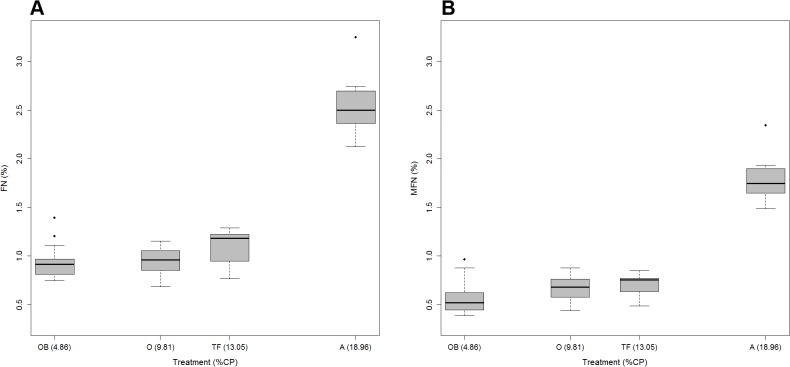
Boxplots of the relationship between nitrogen concentrations and experimental feed.(A) Total fecal nitrogen content by treatment; (B) metabolic fecal nitrogen content. X-axis is proportional to the crude protein content (%) of the treatments. The median is represented by the thick horizontal line; the box is defined by the 25th and 75th percentiles (lower and upper quartile). The dotted line is 1–5 times the spread. Treatments: OB, Oat/barley straw; O, Oat hay; TF, Tall fescue hay; A, Alfalfa hay. N = 20 (OB and O); N = 10 (TF and A).